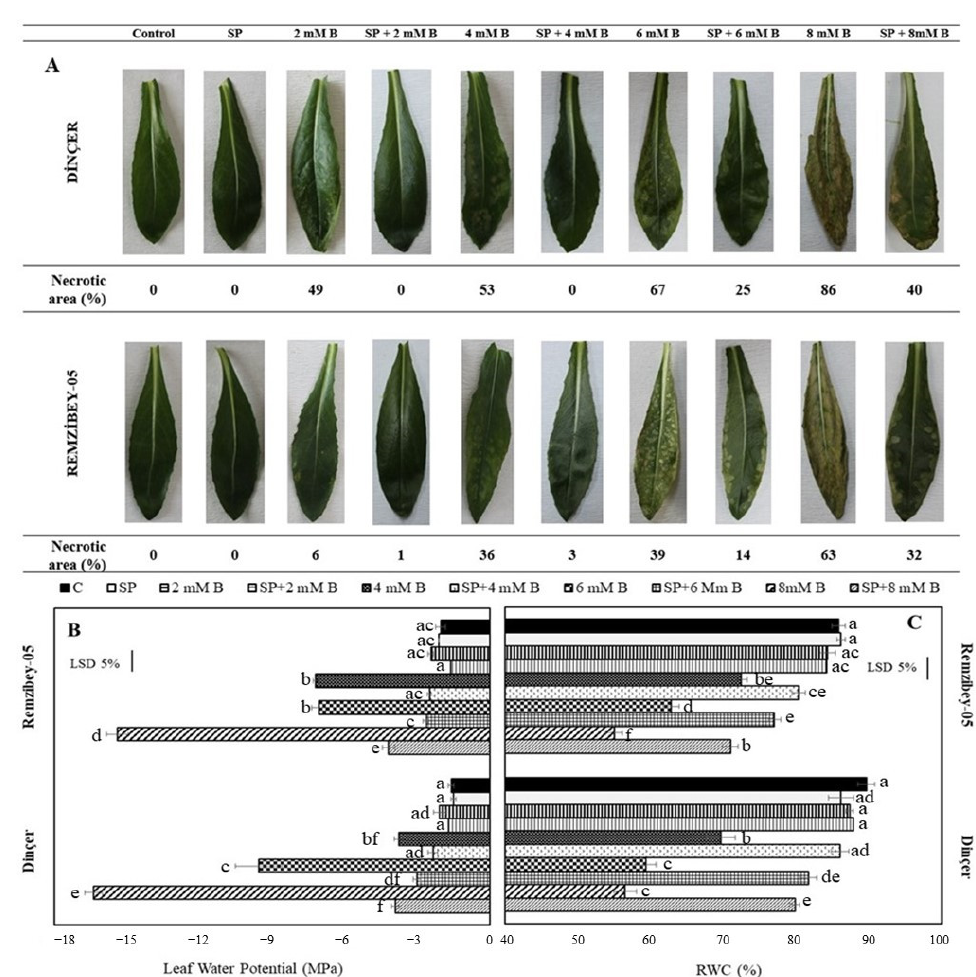
Figure 2. The image of necrosis in safflower leaves exposed to toxic B with or without SP and % values of necrotic areas according to leaf area ( A ). B treatments with or without SP induced changes on the leaf water potential ( B ) and relative water contents (RWC) ( C ) in safflower cultivars. The values are presented as the mean ± standard error (SE), n = 3 for necrotic area and n = 6 for leaf water potential and RWC. The bars and different letters indicate significant difference between treatments and cultivars at p < 0.05 according to the LSD test.